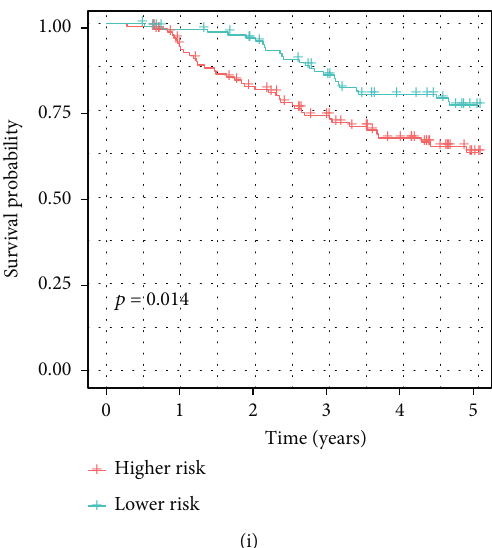
Figure 4: Construction of the prognostic prediction model and model validation. (a, d, g) Risk score (top), disease-free survival (middle) of the patients, and expression pro fi les of the six ferroptosis-related genes (bottom) in TCGA training, TCGA internal validation, and GSE21653 external validation sets. (b, e, h) The areas under the curve of the time-dependent ROC curves show and veri fi ed the prognostic performance of the risk scores in TCGA training, TCGA internal validation, and GSE21653 external validation sets. (c, f, i) Kaplan – Meier curves for disease-free survival in the high- and low-risk groups in TCGA training, TCGA internal validation, and GSE21653 external validation